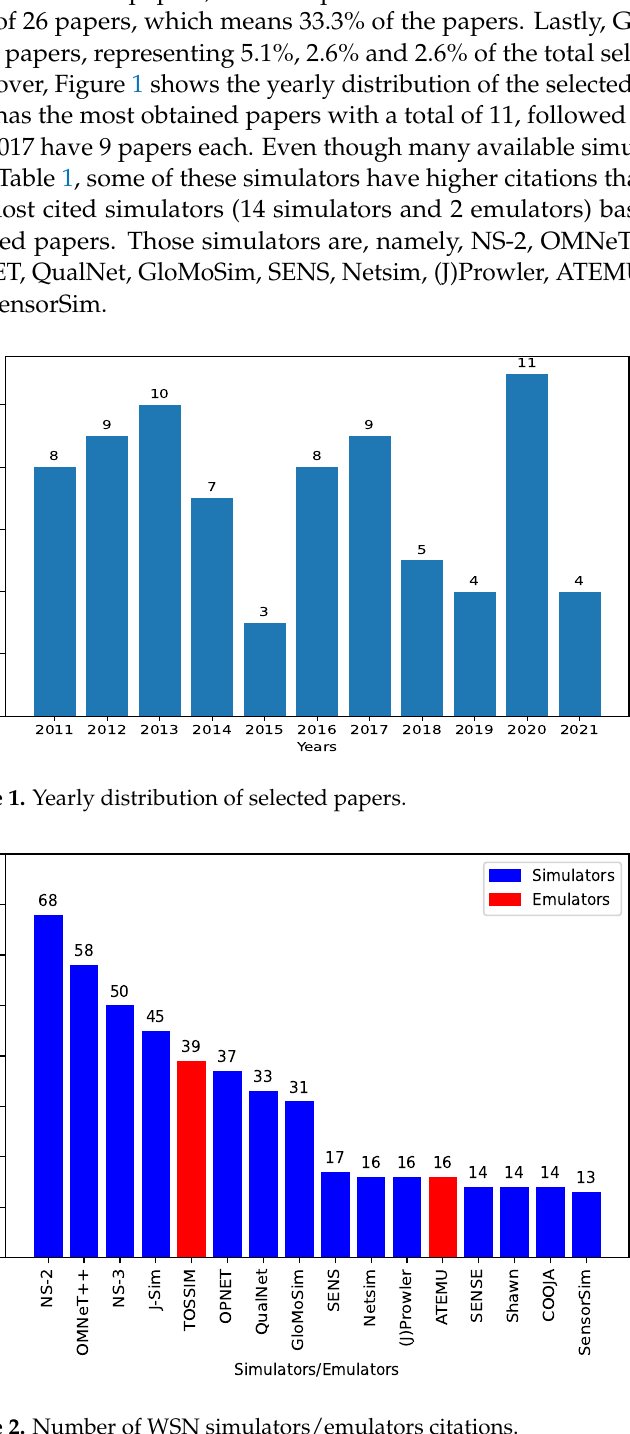
Figure 2. Number of WSN simulators/emulators